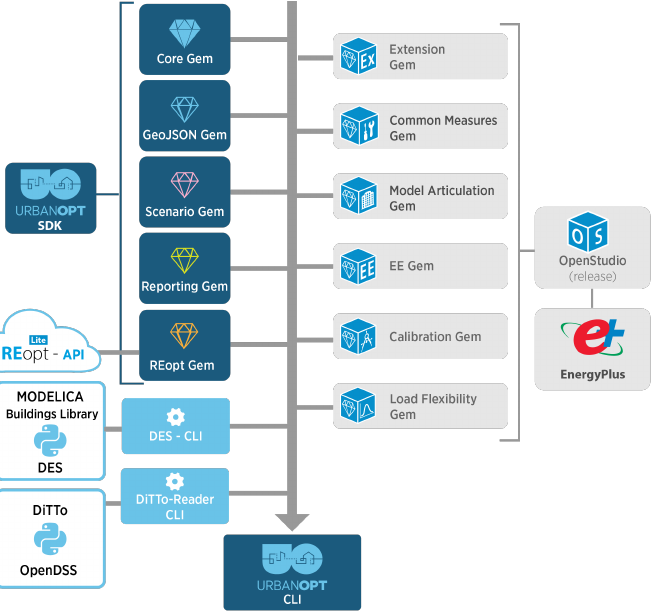
Figure 3. URBANopt SDK Gem structure. Available online: https://docs.urbanopt.net/ (accessed on 28 July